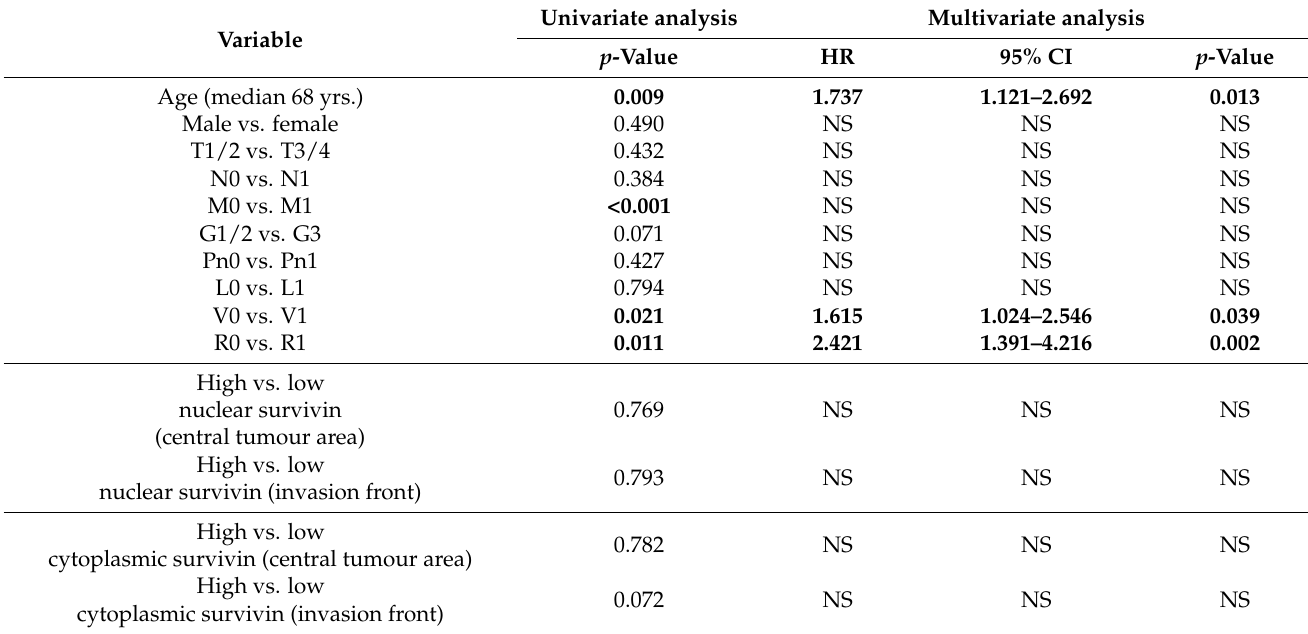
Table 4. Overall survival analysis 1 .